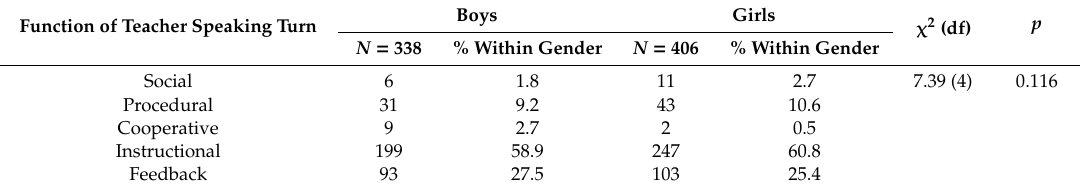
Table 2. Chi-square test of independence of gender and function of teacher speaking turn.